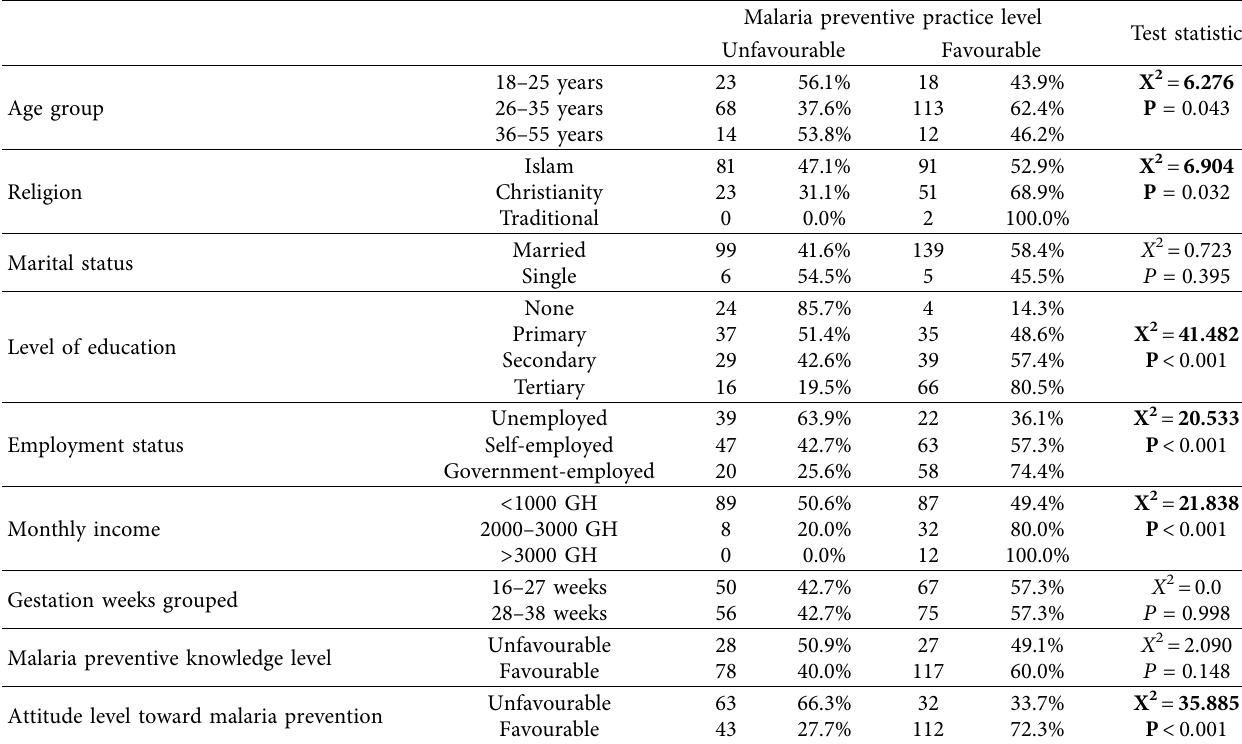
Table 5: Chi-square analysis for factors associated with pregnant women practice level on malaria